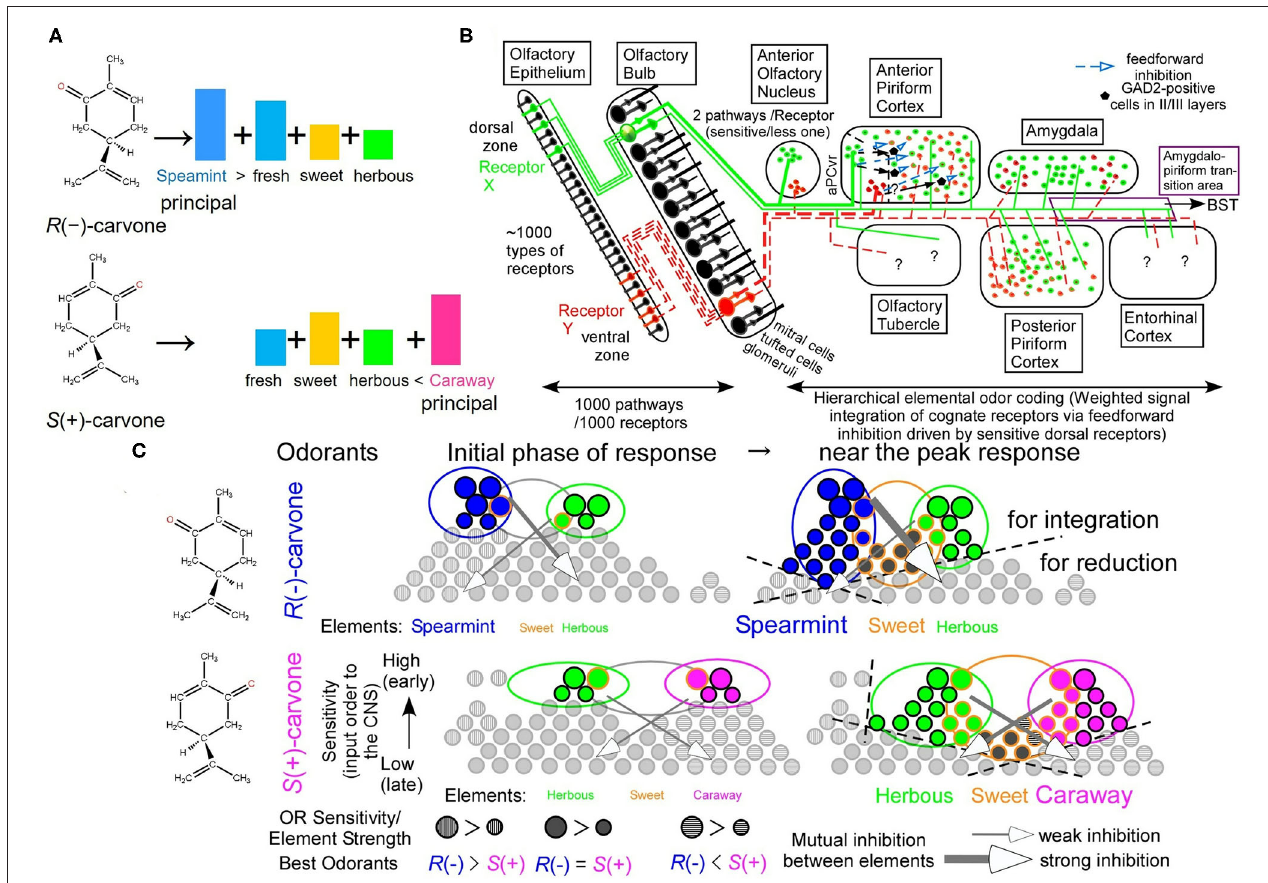
FIGURE 1 | Hierarchical elemental odor coding in olfaction. (A) Schematic diagram of similar but different odors of carvone enantiomers in a hierarchical elemental odor coding. Predicted relative intensities of elemental odors differ between the enantiomers. (B) Olfactory pathway from the olfactory epithelium to the olfactory cortex (Modified from Sato et al., 2008). Pyramidal cells in the anterior piriform cortex, where elemental odors are likely represented by addition and subtraction between signals from multiple receptors via the feedforward inhibitory signals, are the third neurons from sensory neurons ( Sato et al., 2007, 2014). Predator odors activate the amygdala, the bed nucleus of the stria terminalis (BST), and the anterior pituitary resulting in an increase of adrenocorticotrophic hormone (ACTH) to reduce fear stress (see Matsukawa’s review in this collection). (C) Schematic diagram of receptor signal integrations for principal elemental odors among cognate receptors by inhibitory signals (Sato et al., 2007, 2014, 2016c). These are the cases of carvone enantiomers at the initial phase of odor response and around the peak of receptor responses (See text for the